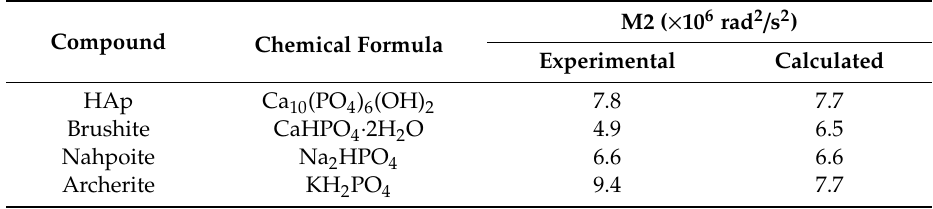
Table 3. Summary of the homonuclear van Vleck second moments M 2 of selected crystalline model compounds determined by the spin-echo method under static